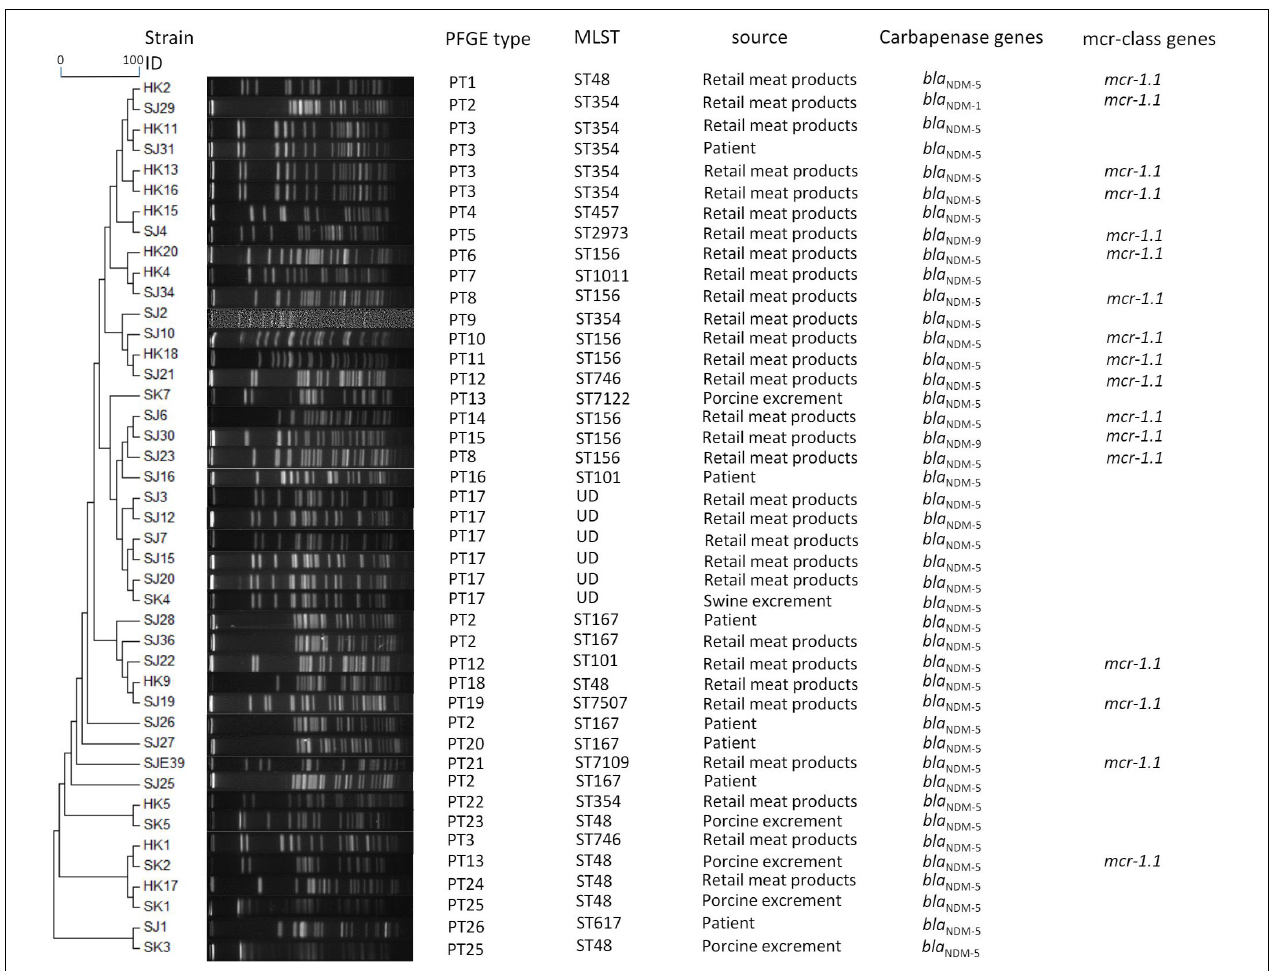
FIGURE 1 | Dendrogram of PTs of chromosomal DNA restriction fragments from 43 E. coli isolates in the present study. Allelic profiles, PTs, STs, source information, carbapenemase genes, and mcr -class genes. The bla NDM − 5 + mcr-1 genotype was identified in ST48, ST101, ST156, ST354, ST7109, and ST7507. The